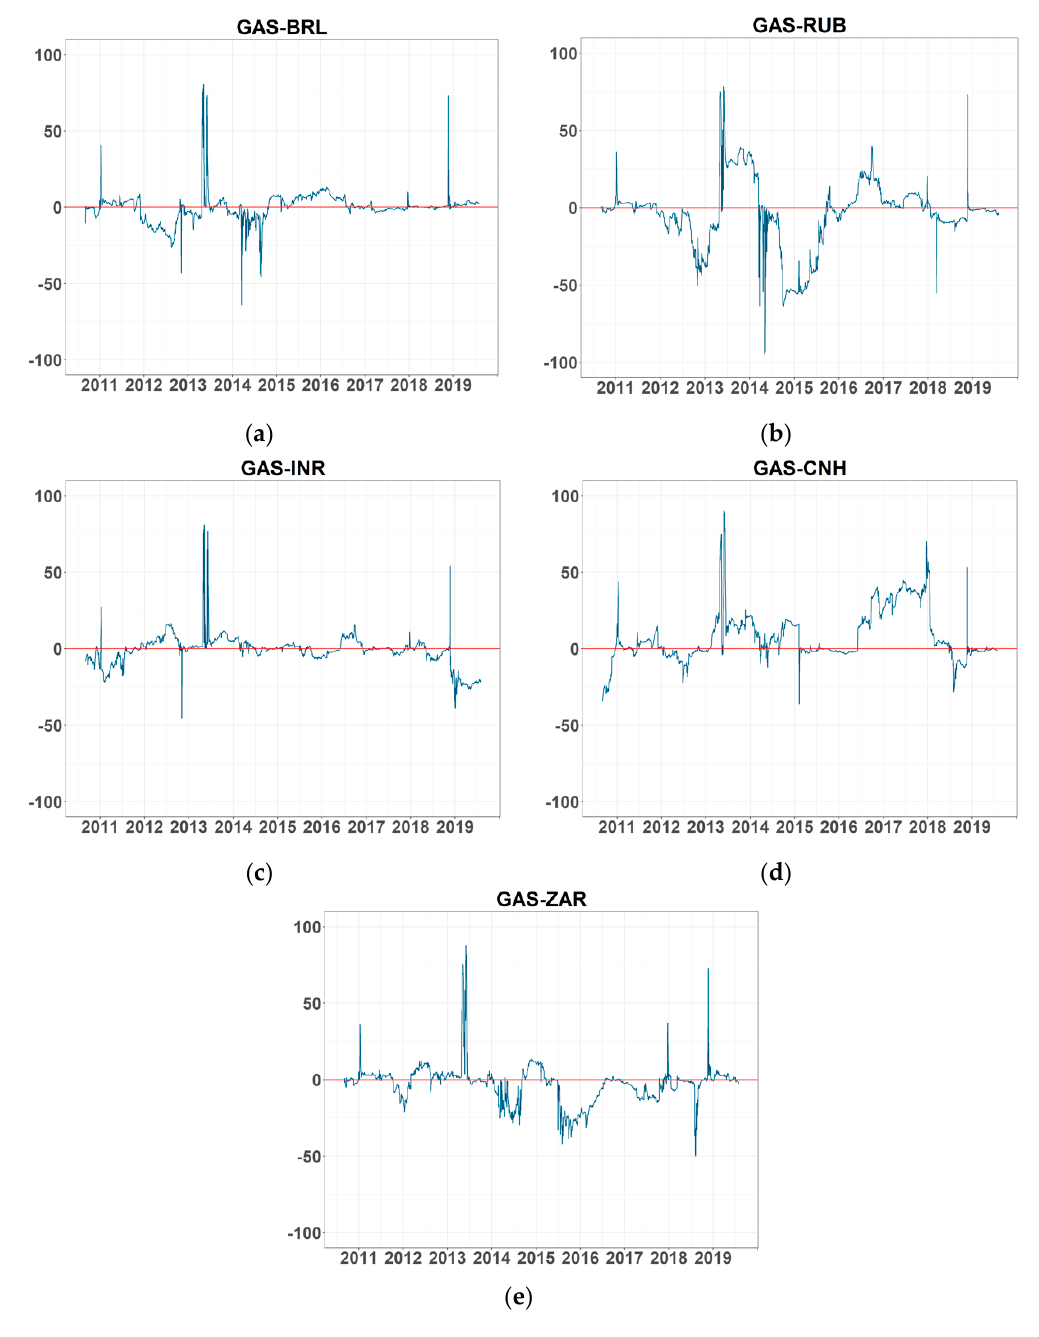
Figure 6. Net pairwise connectedness of volatility. ( a – e ) refer to net pairwise connectedness between the volatility of GASF and BRL, RUB, INR, CNH, and ZAR, respectively. Note: BRL, RUB, INR, CNH, and ZAR are Brazilian Real, Russian Ruble, Indian Rupee, offshore Chinese Yuan, and South African Rand, respectively. GASF is the Henry Hub natural gas futures price.